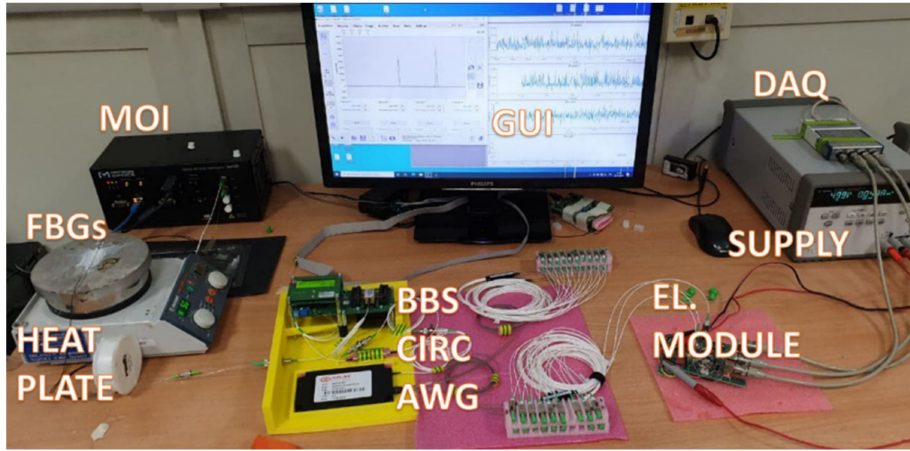
Figure 3. Illustration of the measurement bank with the descripted